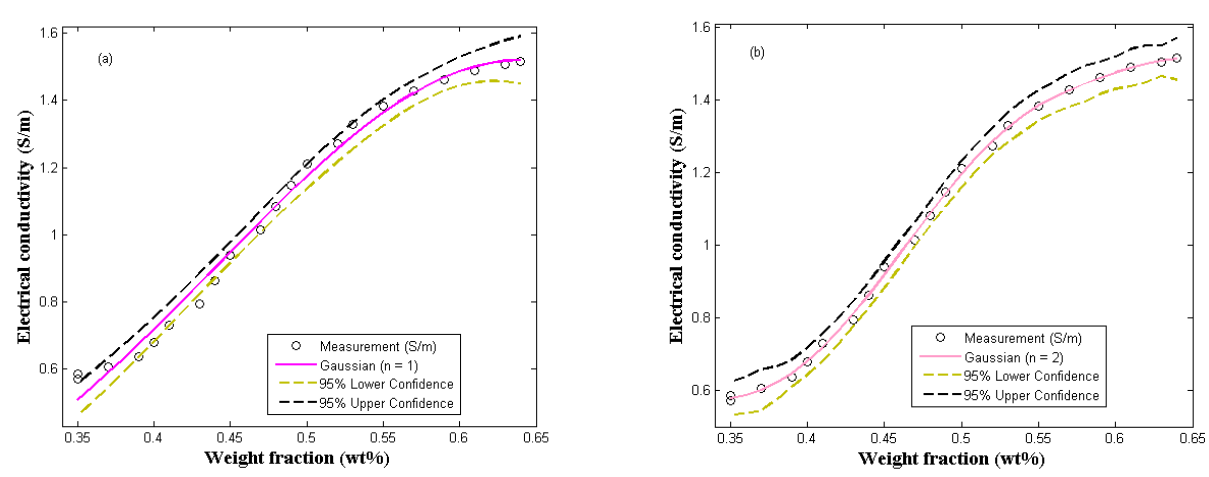
Figure 5. Comparing the dose–response model with experimental measurement.